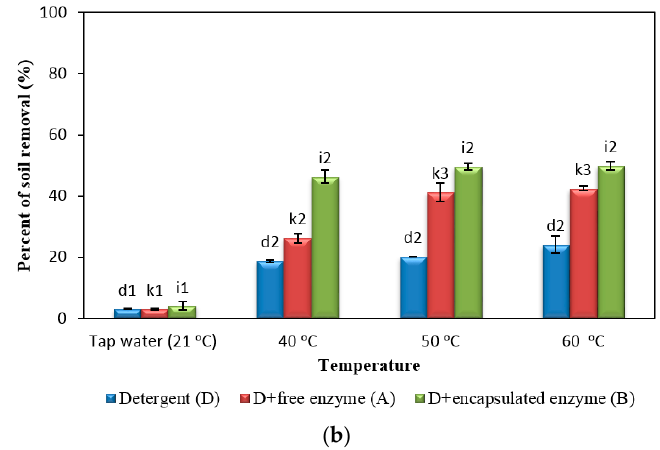
Figure 3. Dishwashing performances of the formulated detergent with free and encapsulated enzymes. The washing was conducted at different water temperatures and hardness. The formulated detergent mixture and enzymes, in ( a ) soft water (0 ppm CaCO 3 ) and ( b ) hard water (350 ppm CaCO 3 ) at 40, 50 and 60 °C. Tap water (21 °C) used as a control. Note: Superscripts b2, h2, i2, i3, i4, d2, k2, k3 and l2 indicated groups that showed a significant difference between the groups when washings were done. All superscripts were obtained using post-hoc tests as shown in Table S3. Data are means ± standard deviation of three determinations and indicated as error bars.